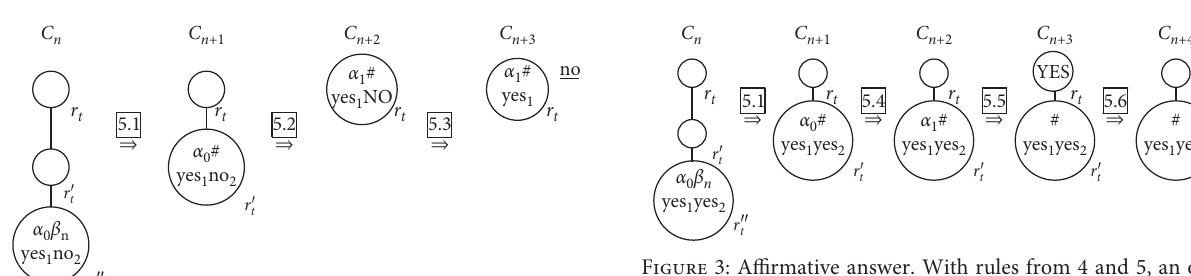
Figure 1: Transport of objects from r rules from 3 are applied to make the objects from M ( i ) their corresponding input membranes.